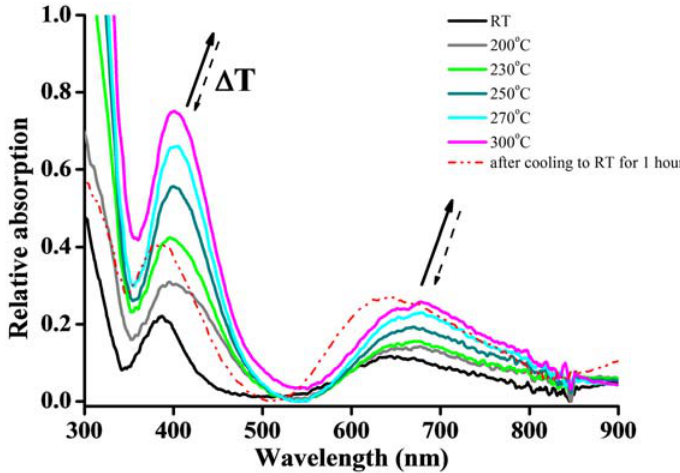
Figure 7. The UV-vis diffuse reflectance spectra of 1 upon heating and cooling from RT to 300